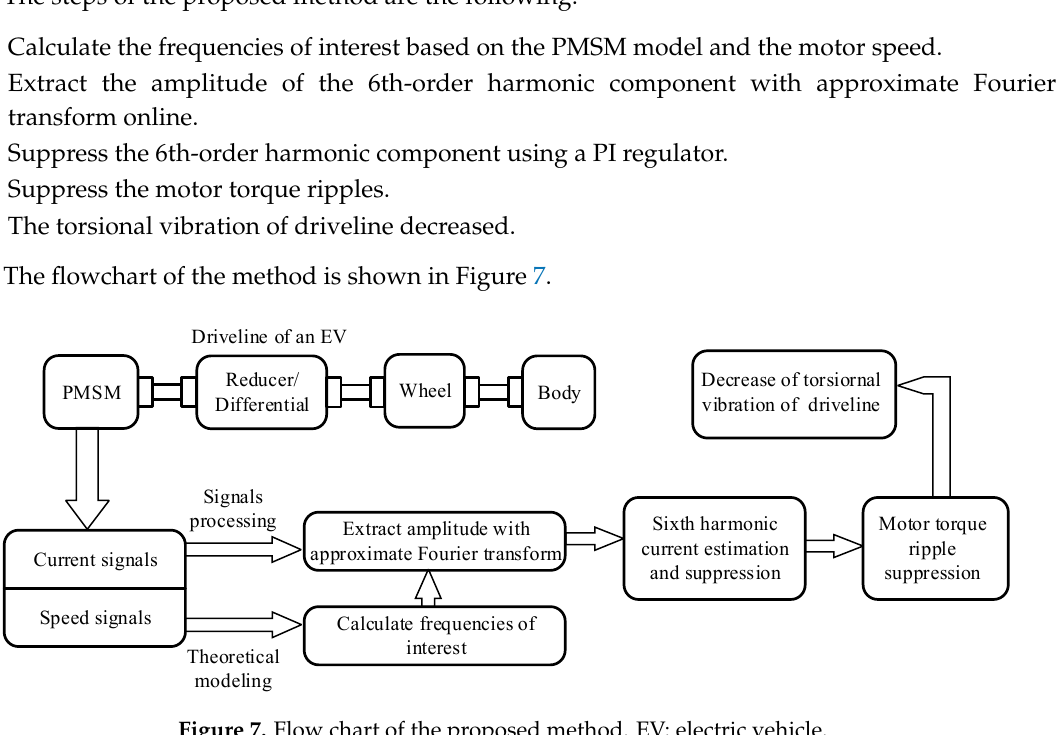
Figure 7. Flow chart of the proposed method. EV: electric vehicle.